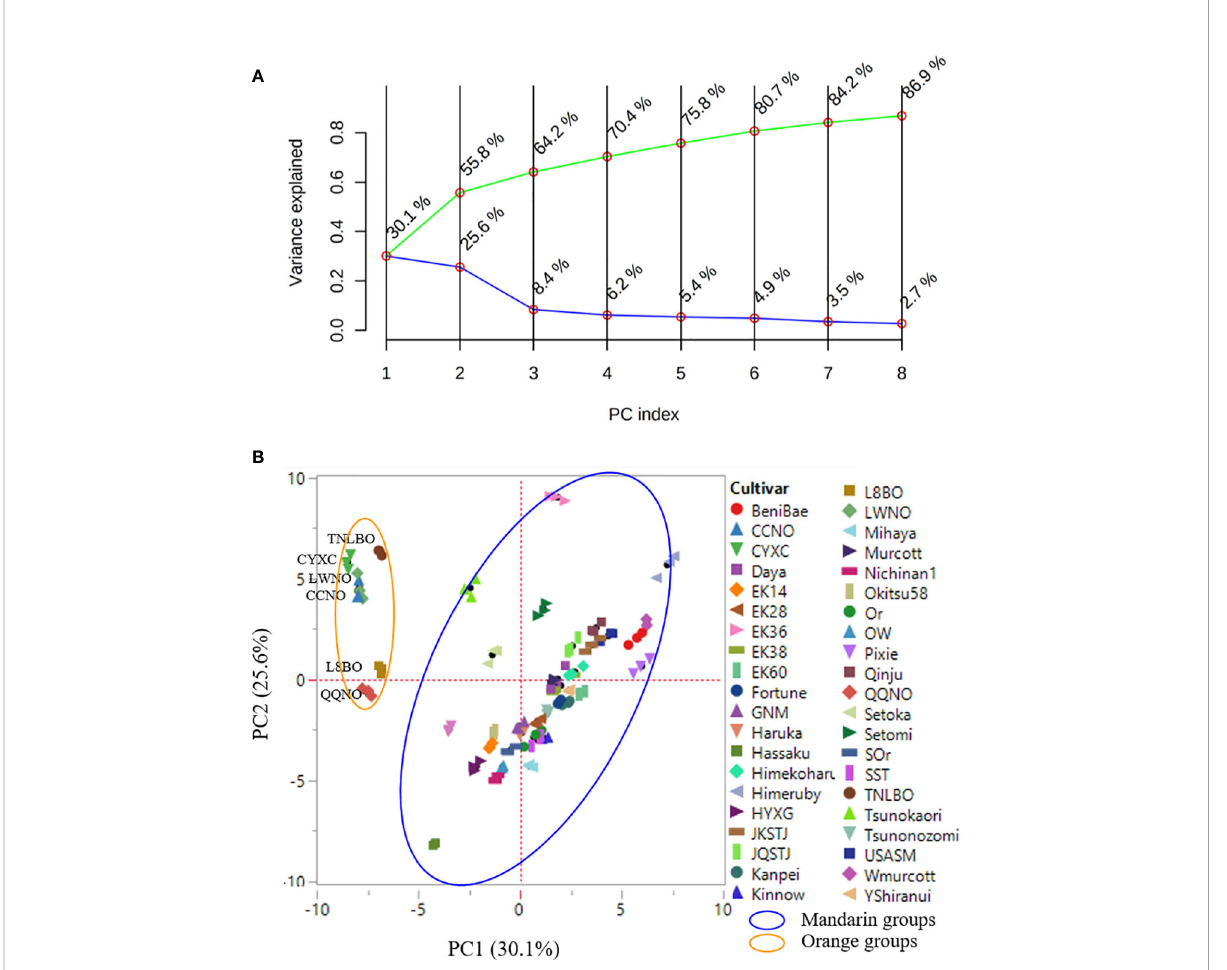
FIGURE 4 Principal component analysis (PCA) scree plot (A) and score plot (B) . Data points representing three biological replicates are ploted in close proximity, and in (B) the mandarin and orange group cultivars can be seen to form distinct clusters. Values in parentheses along the axes indicate the variance